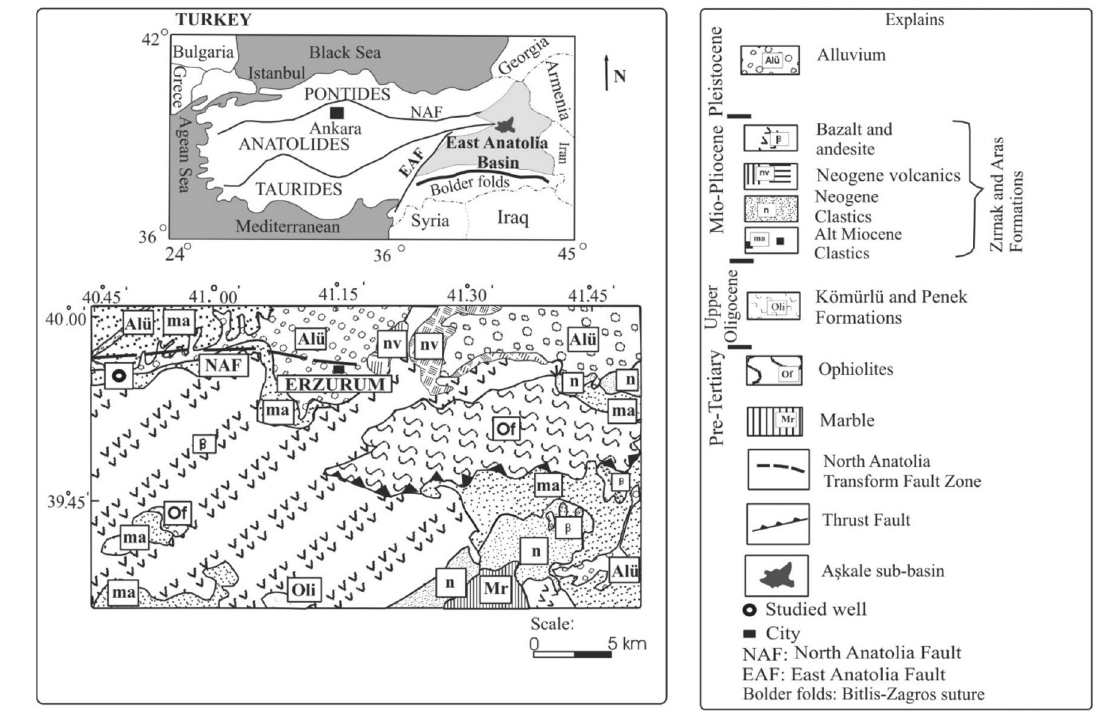
Fig. 1 Location map of Aşkale sub-basin, East Anatolia, Turkey (modified from Şahintürk et al.